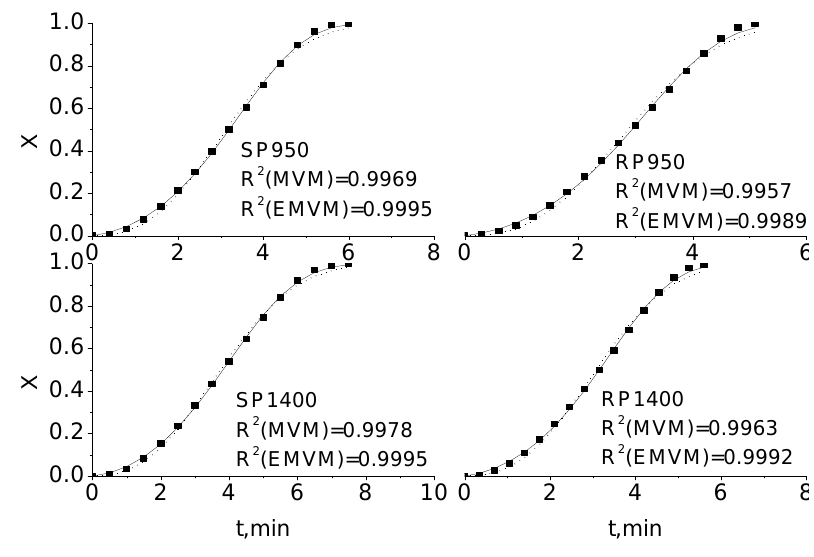
Figure 6. Carbon conversions versus gasification time for coal char gasification at the gasification temperature of 1,400 °C. Experimental data ( ■ ); MVM (  ); EMVM